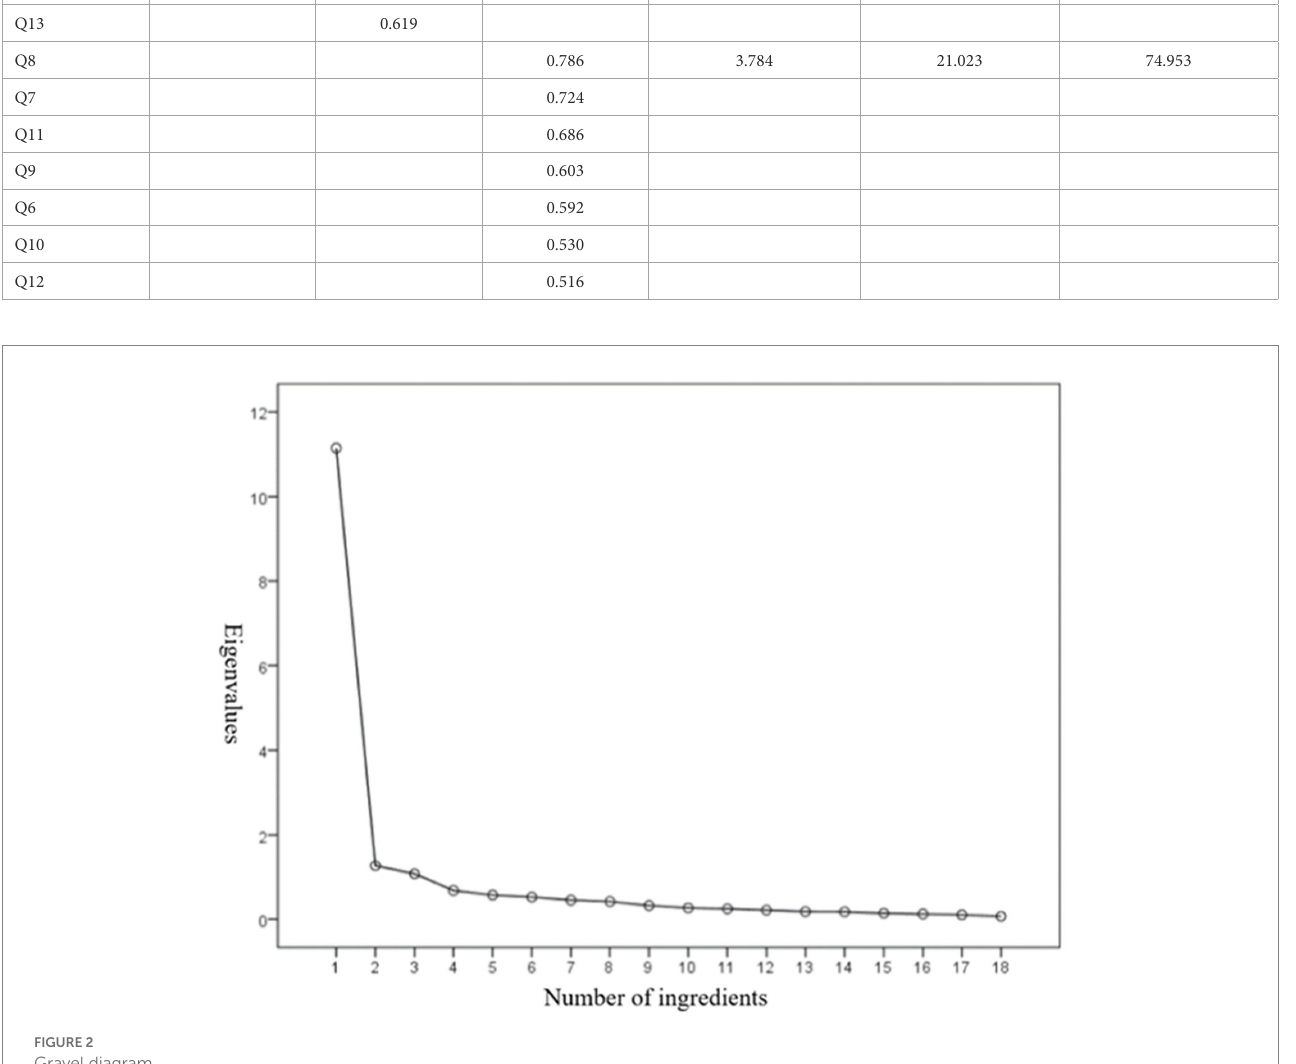
FIGURE 2 Gravel